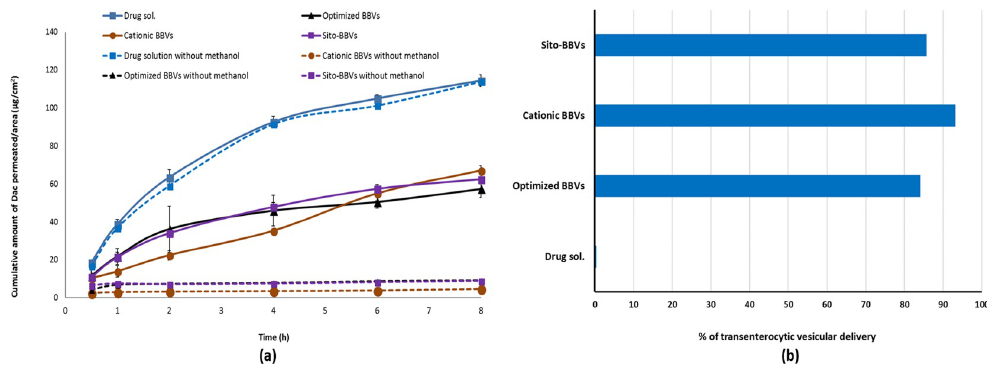
Fig 4. (a) Cumulative amount permeated per unit area of DAC from ABBVs, CBBVs, Sito-GBBVs and drug solution through non-everted rat intestine in 0.9% saline at 37˚C. Data presented as mean ± SD (n = 3). Dotted line: before dilution with methanol. Solid line: after dilution with methanol. (b) Percent of transenterocytic BBVs delivered through intestinal rat epithelial cells